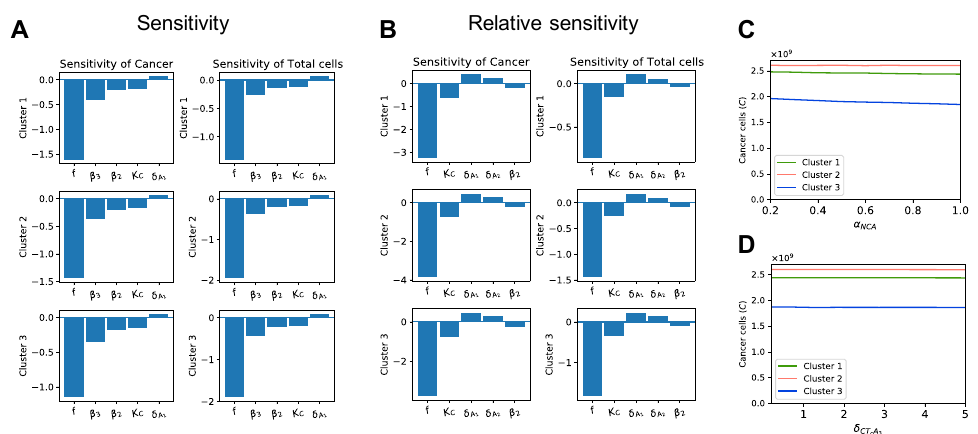
Figure 4. Sensitivity of chemotherapy-related parameters. Sub-figure ( A ) shows the local sensi- tivity of the 5 most sensitive treatment-related parameters with respect to cancer cell population and total cell population. Sub-figure ( B ) shows the local relative sensitivity of the 5 most sensi- tive treatment-related parameters with respect to cancer cell population and total cell population. Sub-figures ( C , D ) display the cancer cell population after treatment with different values of α NCA and δ CT , respectively. c A 3